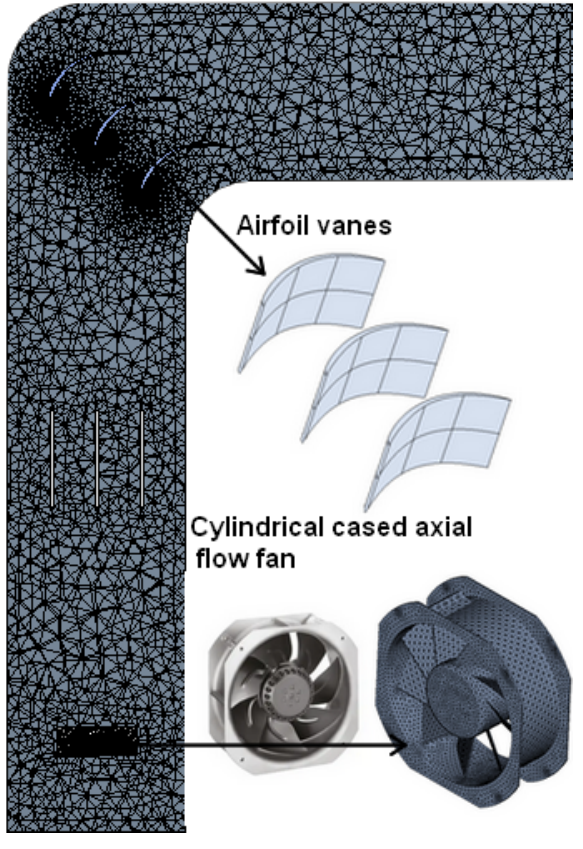
Figure 6. Computational domain (mesh cross-section) of the air duct with the vanes in the shape of thin airfoils. Surface acoustic power level fields for the analysed elbows are presented in Figure 7, and by comparison of noise levels generated at duct surfaces it can be concluded that the elbow with moderate radius generates almost twice lesser noise compared to the elbow with straight boundaries for the same air-duct geometry and for the same flow conditions (low Mach number turbulent flows).